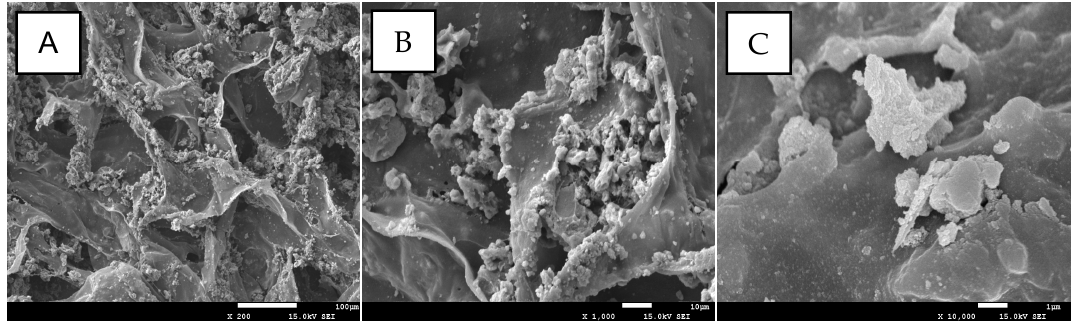
Figure 1. SEM profiles of MNp-Col-IL in different resolutions. ( A ) × 200, ( B ) × 1000, and ( C ) × 10,000.